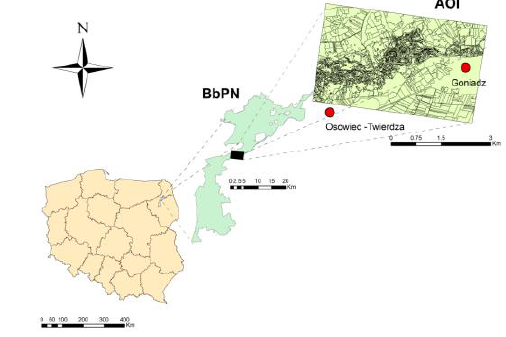
Figure 1. Location of the study site.